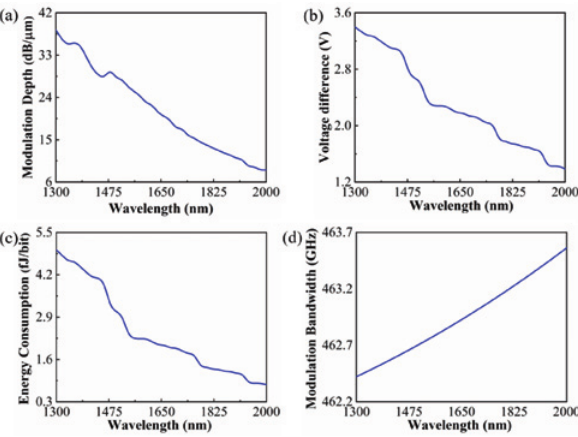
Figure 9: Broadband working characteristics of the modulator. (a) Modulation depth, (b) voltage difference between ‘ OFF ’ and ‘ ON ’ , (c) energy consumption, and (d) 3 dB modulation